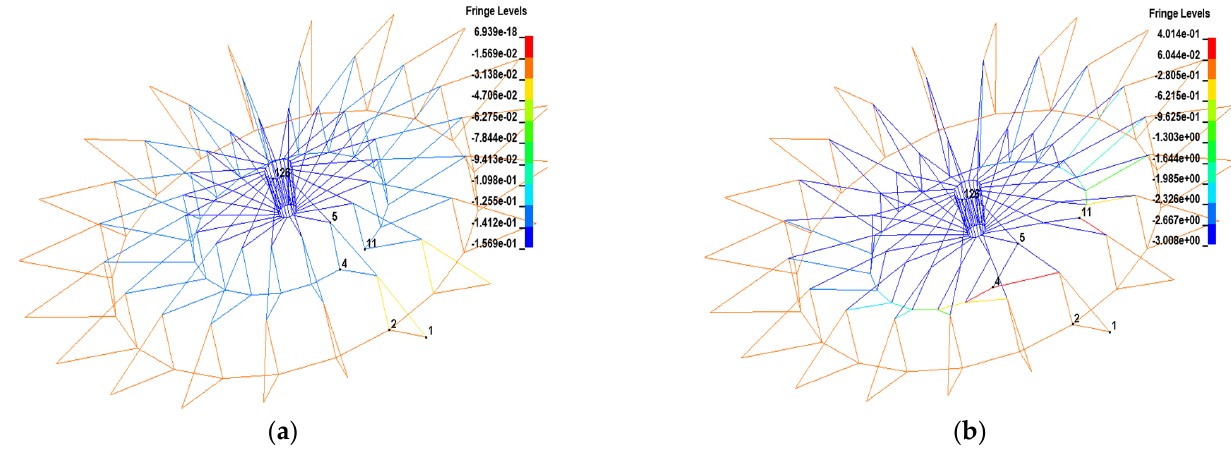
Figure 3. Variations in the vertical displacement over time. ( a ) t = 44 s, ( b ) t = 200 s.